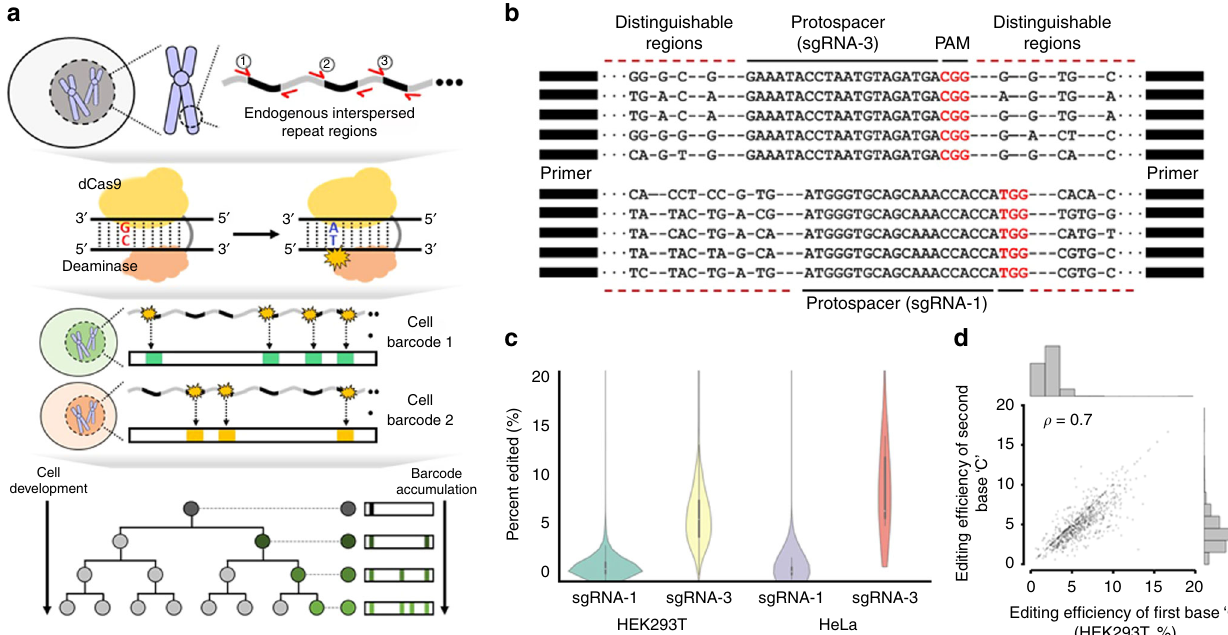
Fig. 1 Targeted deaminase system for lineage tracing. a Schematic overview of the targeted deaminase system. Red arrows indicate the single fl anking primer pair used to amplify the targeted regions. The substitution pattern in the target region served as the cell barcode for tree reconstruction. b Pairwise alignment of fi ve representative target sites for sgRNA-1 and sgRNA-3 design. These regions were ampli fi ed using a single primer pair and alignment distinguished each target site by the different surrounding sequences. c Editing ef fi ciency of the two selected sgRNAs in the target region for HEK293T and HeLa cells. d Correlation of editing ef fi ciency between the fi rst and second base C in a speci fi c window (4 – 8) within the sgRNA-3 spacer sequence in HEK293T cells (Spearman ’ s correlation = 0.6 for HeLa cells). The source data are available in the Source Data fi